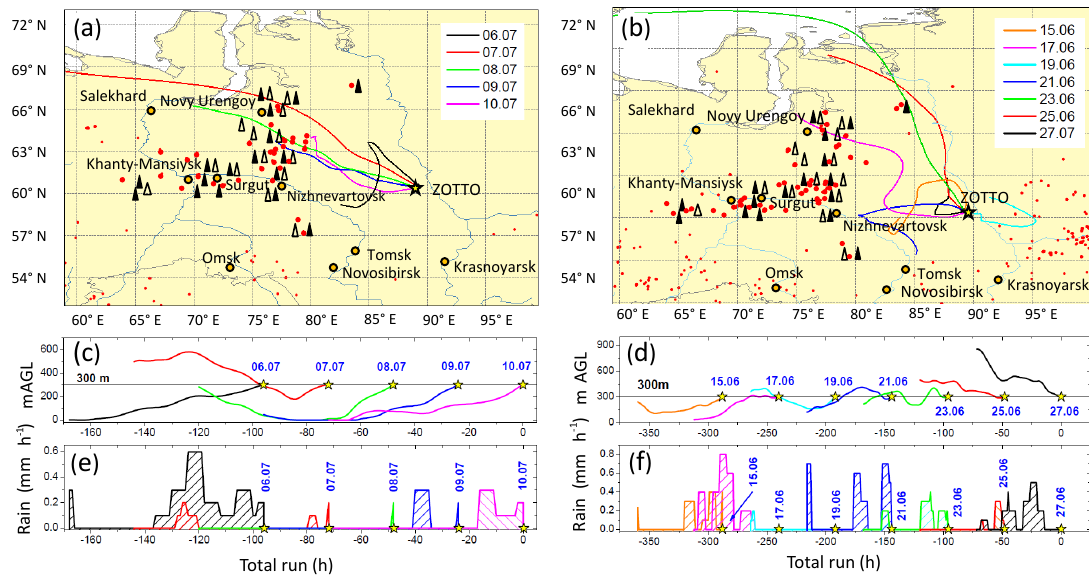
Figure 13. Figure shows 72h HYSPLIT air mass trajectories during clean periods at ZOTTO at 300m from 6 to 10 July 2011 with 24h intervals (a) and from 15 to 27 July 2013 with 48h intervals (b) . Bold red dots indicate the hot spots, which are most likely associated with gas flaring; open and solid triangles stand for gas and oil production fields, respectively; panels (b, d) show trajectory heights above ground level (a.g.l.) and panels (c, f) rain rate (mmh − 1 ) along the air mass trajectories. Stars and dates show the arrival times of air masses (c, d, e, f)